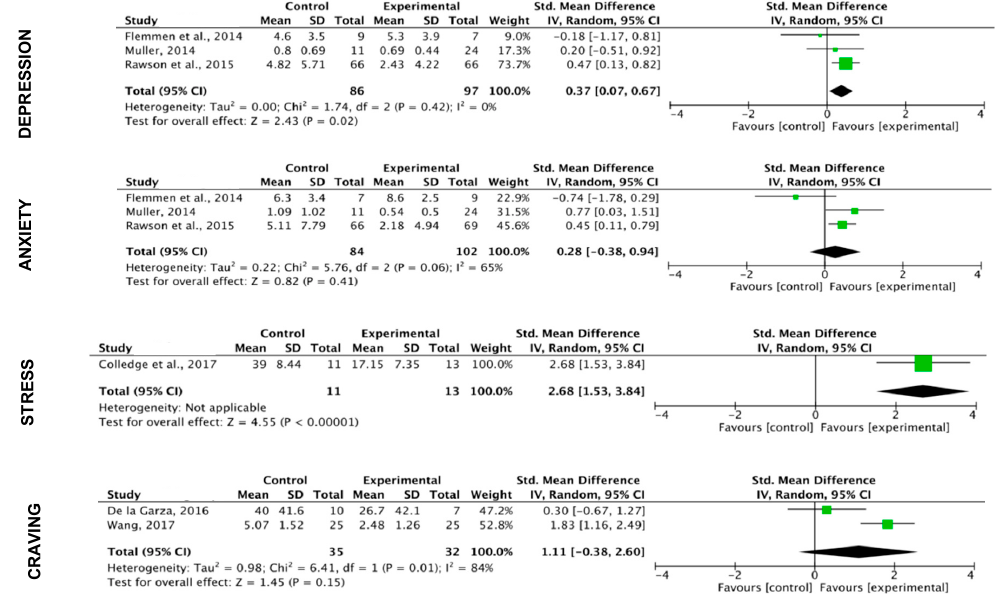
Figure 8. E ff ect of physical fitness programs on mental disorders and Figure 8. Effect of physical fitness programs on mental disorders and craving.